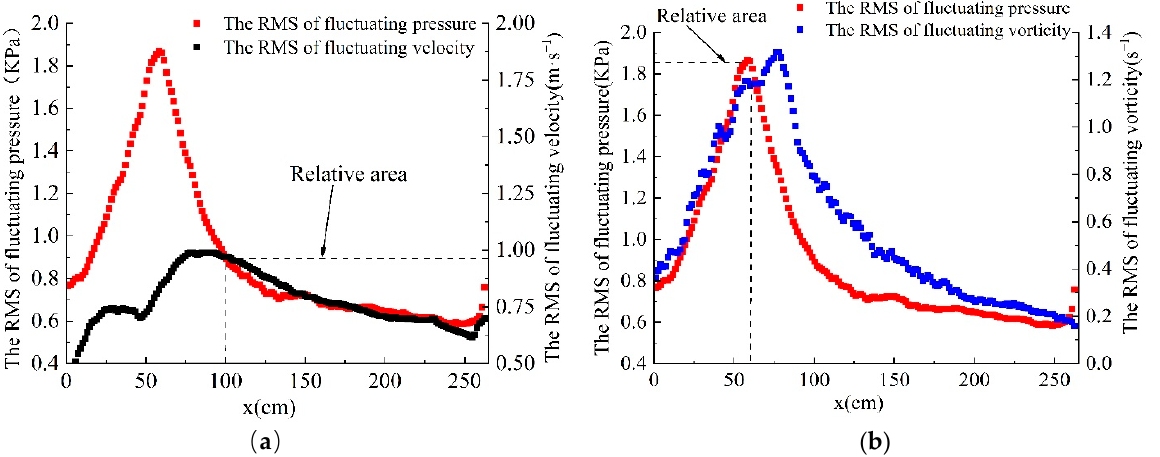
Figure 11. Distribution of fluctuating velocity and vorticity in the horizontal section of the stilling basin slab: ( a ) Distribution of fluctuating velocity; ( b ) Distribution of fluctuating vorticity.